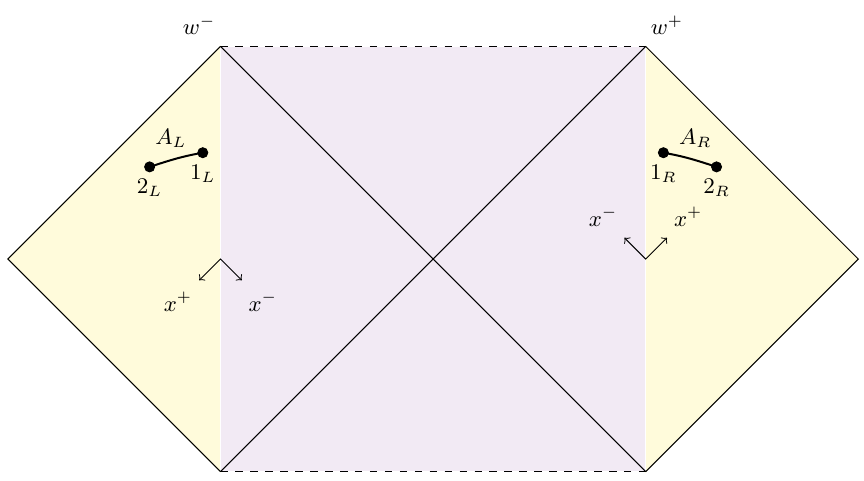
Figure 2 . The Penrose diagram showing the eternal black hole. The bath regions L and R are half Minkowski spaces glued onto the central AdS space. There are two intervals A L and A R in each bath as